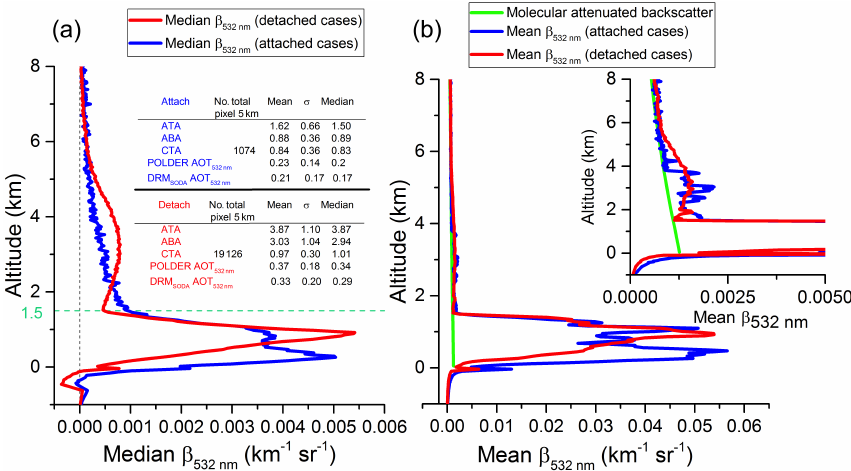
Figure 10. Median (a) and averaged (b) backscatter profiles (km − 1 sr − 1 ) for aerosol layer detached from the cloud layer (red) and aerosols attached to the top of the cloud (blue), for a period of 4.5 years on the global scale. For comparison, the molecular attenuated backscatter profile is shown as a green line. The data were filtered for a cloud top altitude lower than 1.5km, a cloud optical thickness (COT) larger than 5 and for a DRM SODA AOT at 532nm larger than 0.1. The number of 5km horizontal-resolution pixels is also shown. The mean, standard deviation ( σ) and median of aerosol top altitude (ATA), aerosol base altitude (ABA) and cloud top altitude (CTA) are given for each situation. Same values are shown for POLDER AOT at and DRM SODA AOT at 532nm.